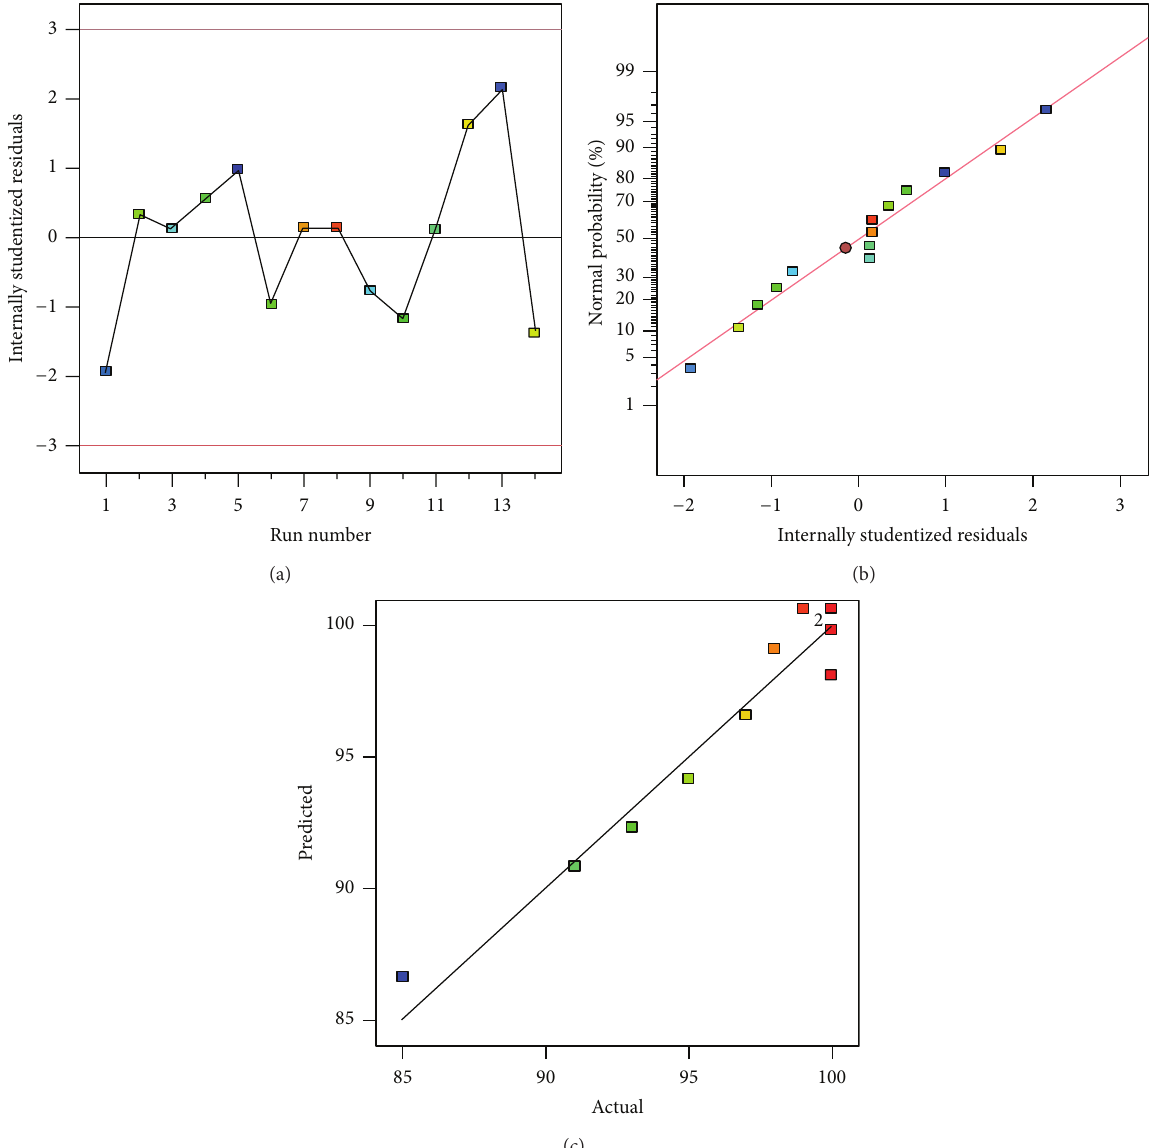
Figure 1: Residual analysis of the predicted model for sulfur removal. (a) Residual versus the run number, (b) normal probability plot of residuals, and (c) predicted values against the actual values of